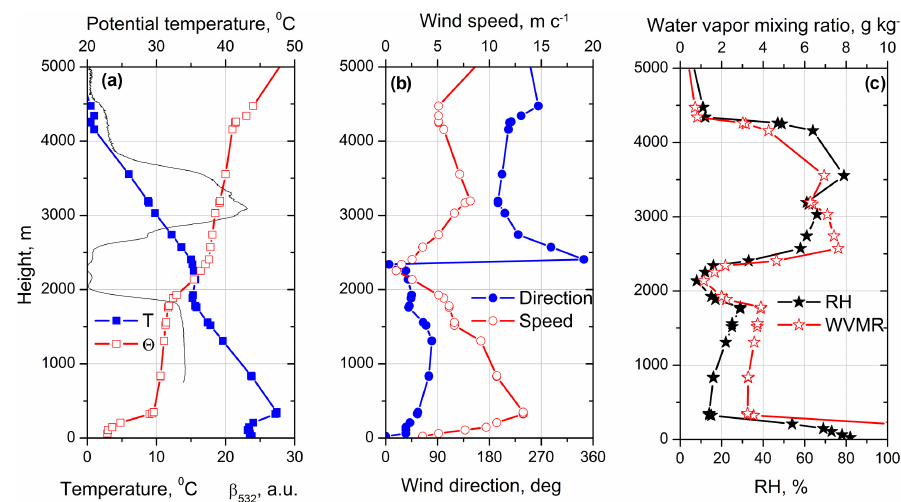
Figure 6. Vertical profiles of (a) temperature T , potential temperature (cid:50) , (b) wind direction and speed, and (c) relative humidity (RH) and water vapor mixing ratio (WVMR) measured by the radiosonde in Dakar at 00:00UTC on 25 December 2015. Solid line in plot (a) shows the aerosol backscattering coefficient at 532nm in arbitrary units measured by the Raman lidar at 21:00UTC on 24 December.